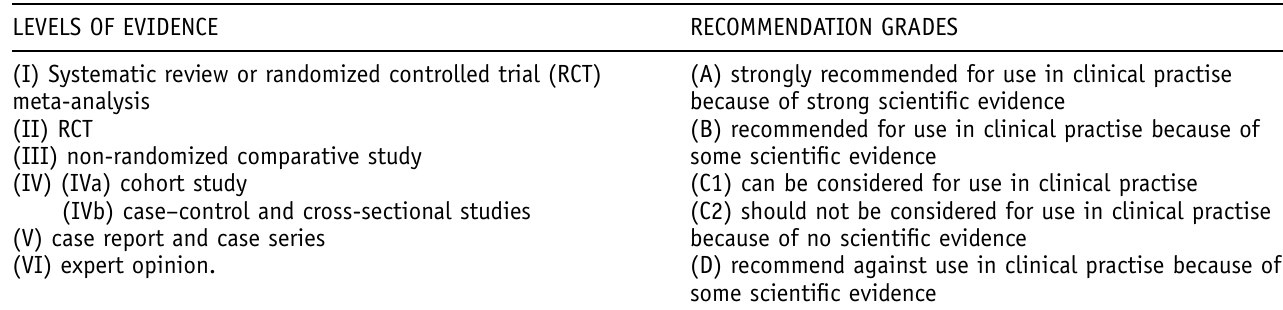
Table III. Levels of evidence and recommendation grades for consensus statement on treatment of DM and JDM [21]. LEVELS OF